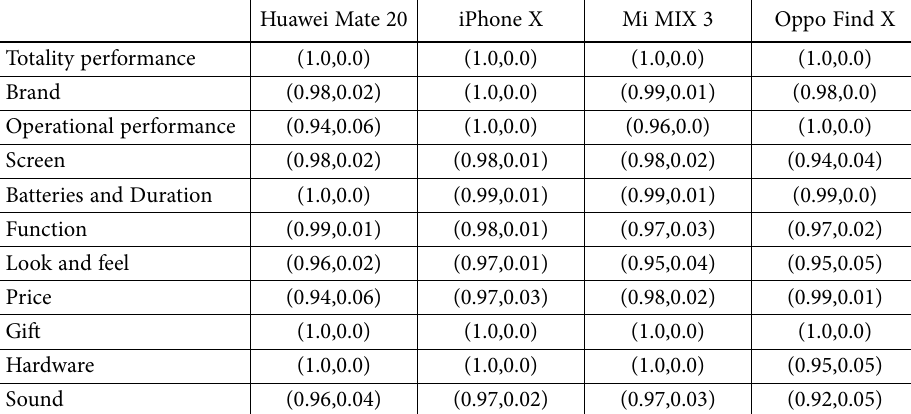
Table 10. The intuitionistic fuzzy decision matrix of